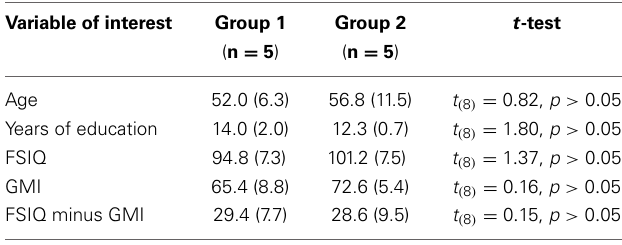
Table 3 | Demographics and neuropsychological tests scores as compared to patients tested by Jeneson et al.